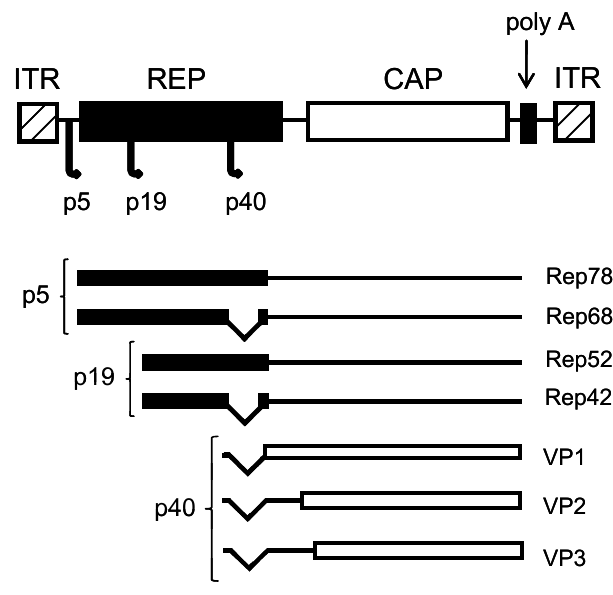
Figure 1. Map of the wild-type adeno-associated virus (AAV) genome. REP and CAP genes flanked by inverted terminal repeats (ITR), three promoters